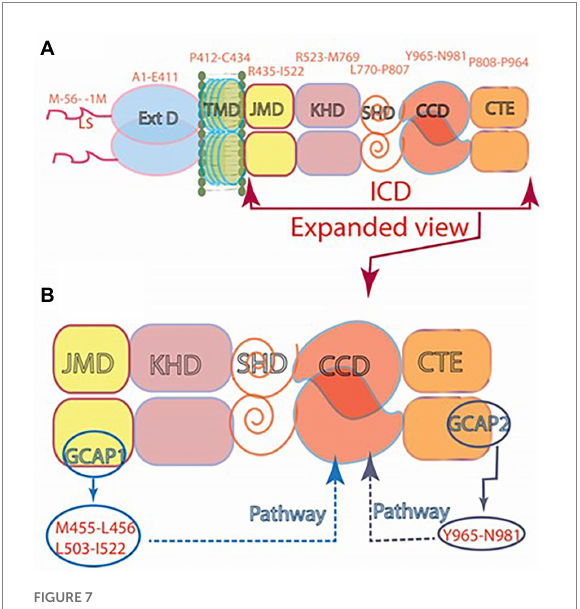
FIGURE 7 (A) Modular construction of the ROS-GC1 dimer. A 56 aminoacid leader sequence (LS) precedes the extracellular domain (ExtD) in the nascent, immature protein. All signaling events occur in the intracellular domain (ICD), which is composed of: JMD, juxtamembrane domain; KHD, kinase homology domain; SHD, signaling helix domain; CCD, catalytic core domain; and CTE, C-terminal extension. (B) Interaction with GCAP1 and GCAP2. Two specific switches for Ca 2+ sensing subunits, one for GCAP1 in the JMD, and one for GCAP2 in the CTE, are located on opposing sides of the CCD. The MGC complex exists as a dimer of homodimers in which two ROS-GC1s combine either two GCAP1s or two